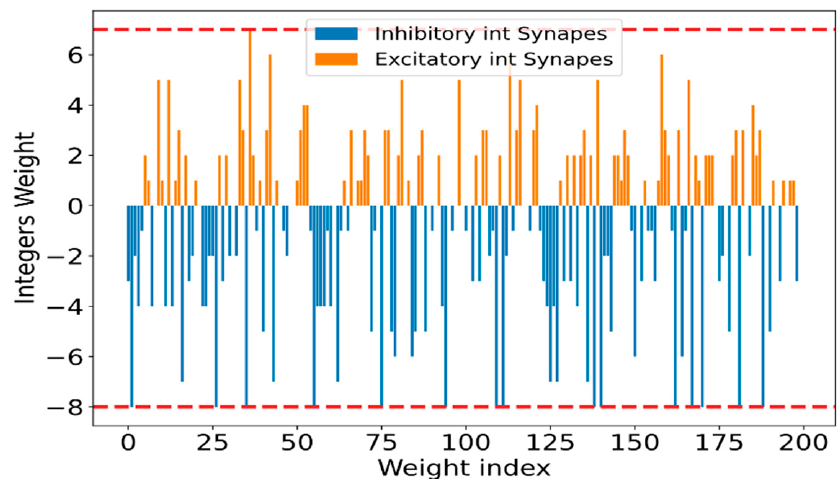
Figure 9. SNN output layer 4-bit integers weight ranged from ( − 8) to (7) as shown in the two red horizontal lines, the integers weights optimized according to Algorithm 2.